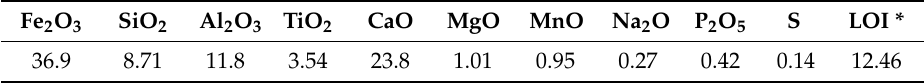
The average chemical composition (wt %) of RM from Ural Aluminum Plant (Kamensk-Uralsky, Russia). Fe 2 O